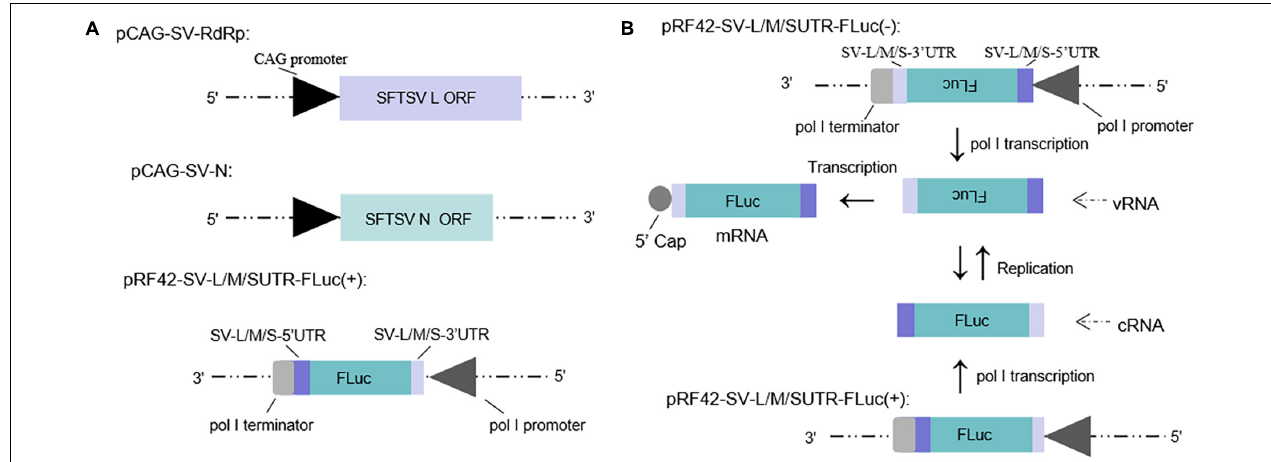
FIGURE 1 | Schematic of the experimental generation of the pol I-driven SFTSV minigenome system and the cDNA-derived virus-like RNA synthesis system. (A) Organization of murine pol I-driven SFTSV L, M, and S minigenome systems. The minigenome system consists of the minigenome plasmid and the expression plasmids of RdRp and N. Briefly, ORF of SFTSV RdRp or N was respectively, inserted into vector pCAGGSP7 by double digestion ( Kpn I and Not I); Firefly luciferase (FLuc) gene flanked by the 5 (cid:48) and 3 (cid:48) UTR of L/M/S was inserted into the pRF42 in antigenome (+) orientation. (B) Transcription and replication in the cDNA-derived virus-like RNA synthesis system of SFTSV. Virus-like vRNAs and cRNAs were respectively, transcribed by pRF42-SV-L/M/SUTR-FLuc (–) and pRF42-SV-L/M/SUTR-FLuc (+) based on murine pol I promoter. Meanwhile, cRNAs can be synthesized by replication using vRNAs as template and subsequently can be used as templates to synthesize vRNA by transcription. The vRNA can also be used as templates to synthesize mRNA through transcription. The 5 (cid:48) capped mRNA can encode the reporter protein (FLuc or EGFP ), which can be used as an indicator for viral RNA synthesis.